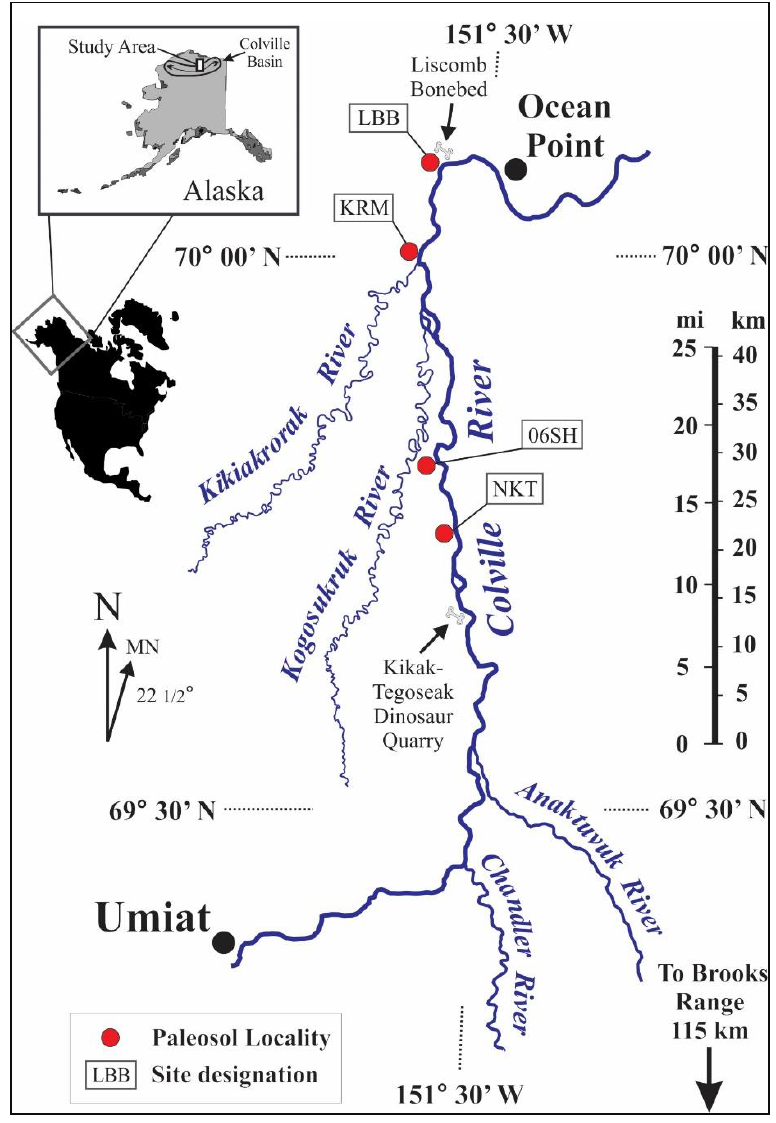
Figure 2. Map of the study area (modified from Flaig et al. [22]) including the four sampled outcrop locations examined in this study: North Kikak-Tegoseak (NKT); Sentinel Hill (SH); Kikiakrorak River Mouth (KRM); and Liscomb Bonebed (LBB).